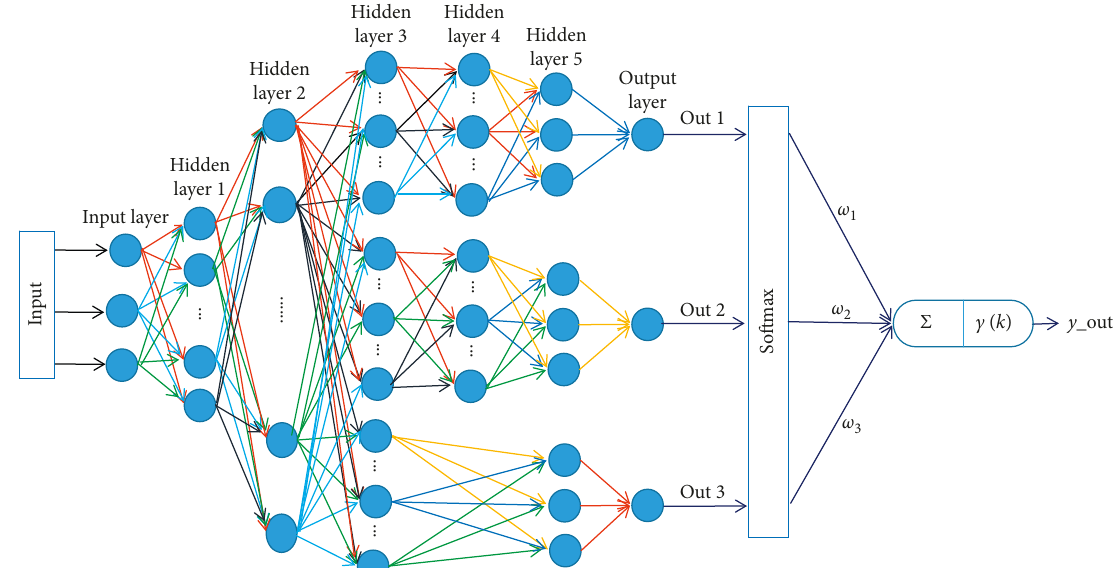
Figure 5: Structure diagram of integrated neural network algorithm based on vote